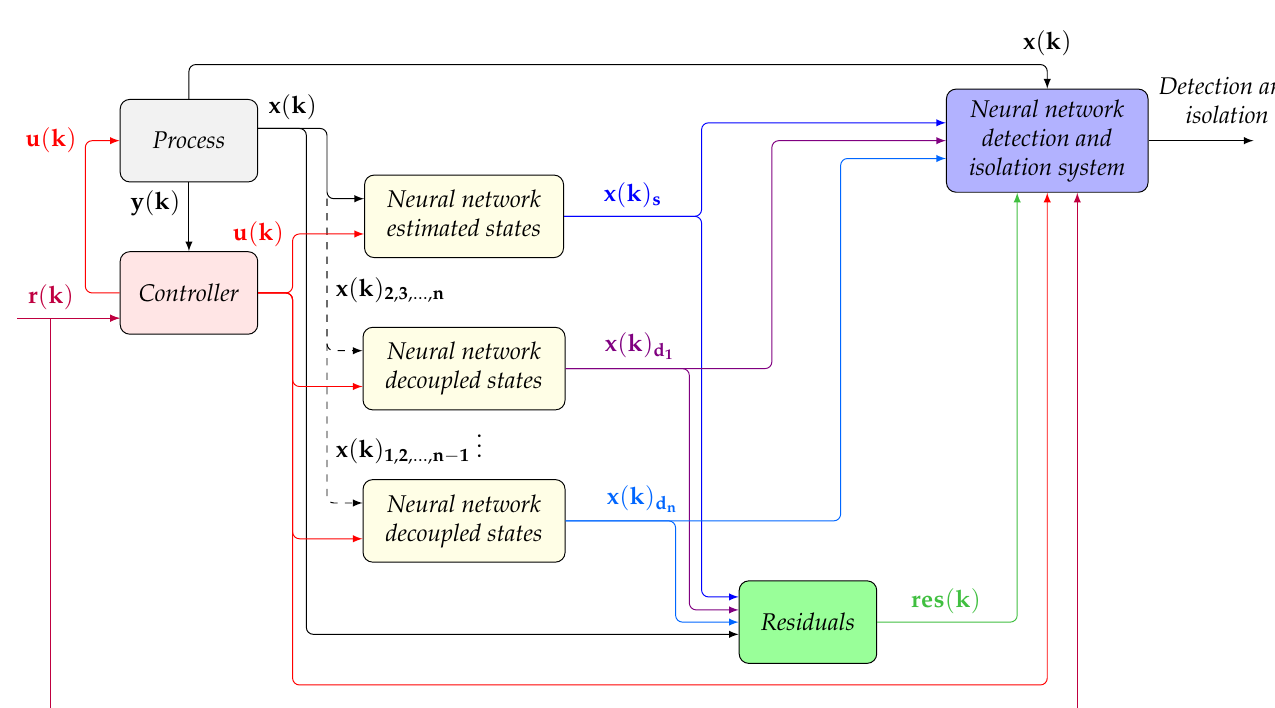
Figure 3. Architecture based on neural networks for the detection and isolation of the cyber attack. Mean squared error (MSE) [75] is adopted as the model’s loss function to train the predicting